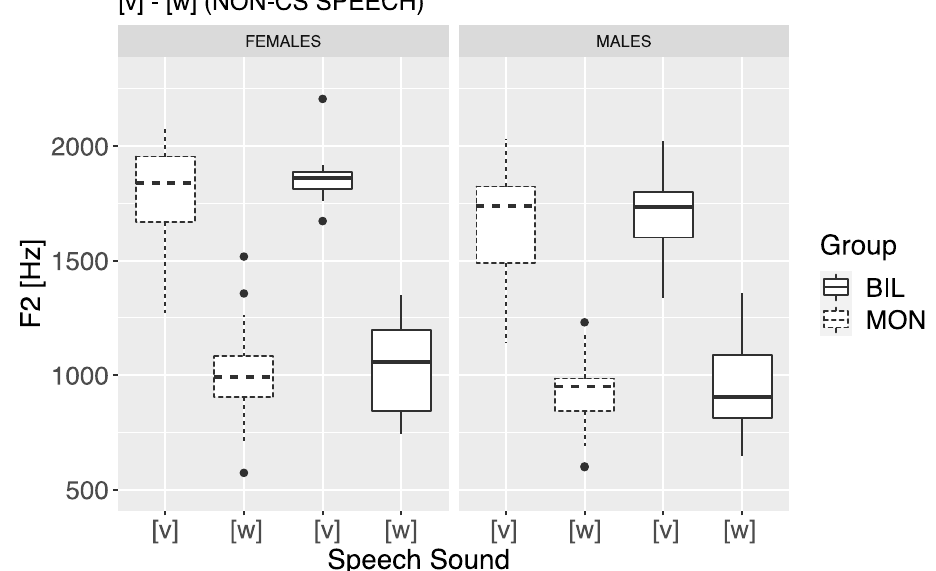
Figure 4. F2 of intended [v] and [w] sounds in English words, spoken by the same MON speakers (dashed) that already appeared in Figure 1, and by the five BIL speakers (solid) in non-CS environments, who were shown to have shifted CS [w] away from non-CS [w]. The left panel shows female data, the right panel male data.